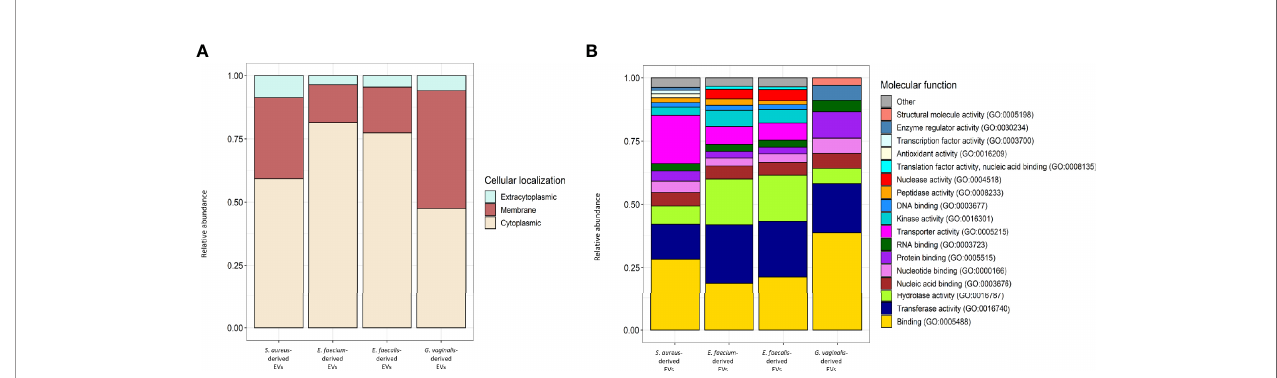
FIGURE 9 | Cellular localization and molecular function GOs of S. aureus , E. faecium , E. faecalis and G.vaginalis- derived EV proteome. (A) Relative abundance of the proteins predicted to have a cytoplasmic, extracytoplasmic, or intracellular localization within each strain-derived EV proteome. Detailed results of TMHMM and SignalP analysis used to predict TM and signal peptide motifs in the EV-related proteins are reported in Tables S1 – S4 . (B) Relative abundance of the proteins belonging to each molecular function ’ s GO within each strain-derived EV proteome; ‘ other ’ includes GO terms with a relative abundance < 1%. Molecular functions were extracted from strain-derived EV proteomes, analyzed in topGO, and categorized in CateGOrizer (Hu et al., 2008) against the GOSlim2 database. Raw data are reported in Tables S1 – S11 ; sa and gv indicate molecular functions that were identi fi ed only in the S. aureus and G. vaginalis- derived EVs proteome, respectively.